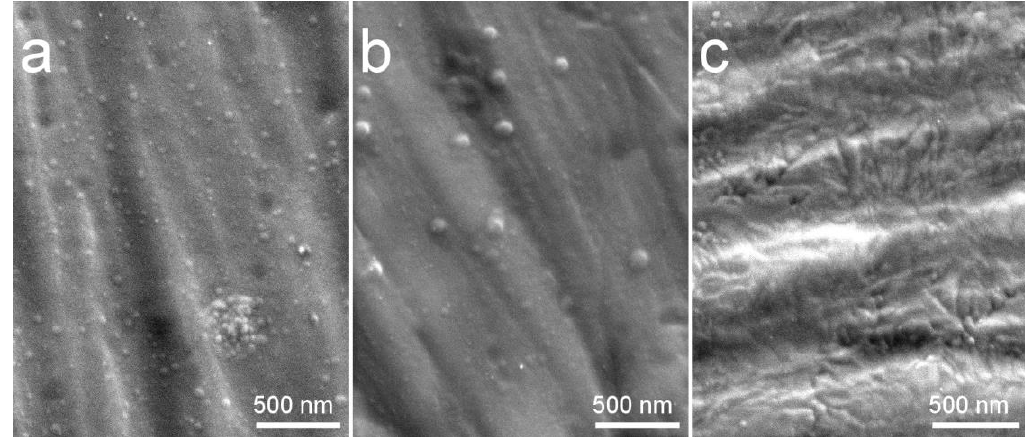
Figure 11. SEM images of Zn-HA coatings deposited at in situ substrate temperature 100 °C ( a ), 300 °C ( b ), and 400 °C ( c